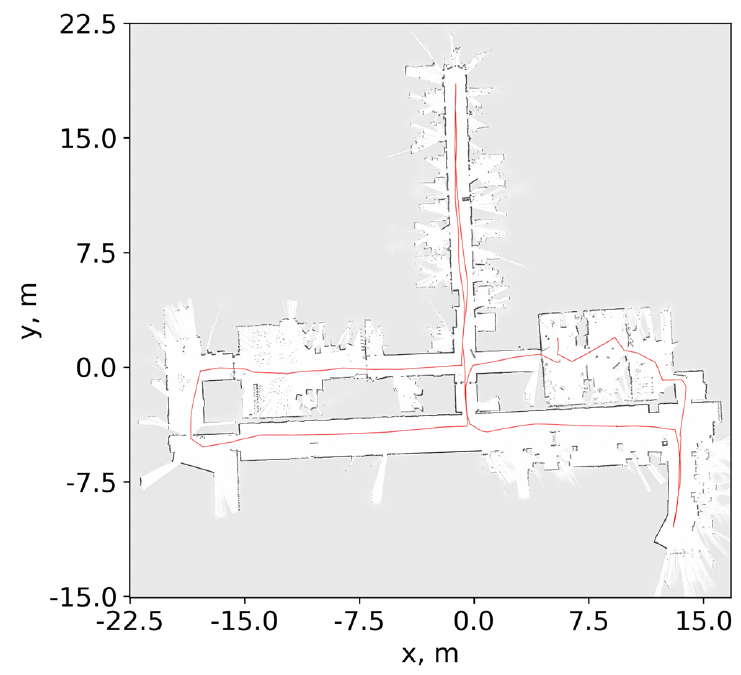
Figure 1. Attachments scan from an actual LiDAR sensor. In the given visual representation, the red indicates the robot’s trajectory, the black shows the data from the LiDAR sensor, the white color is used to indicate the region that was detected by the LiDAR sensor, while the gray color represents the area that was not covered by the sensor’s field of view.